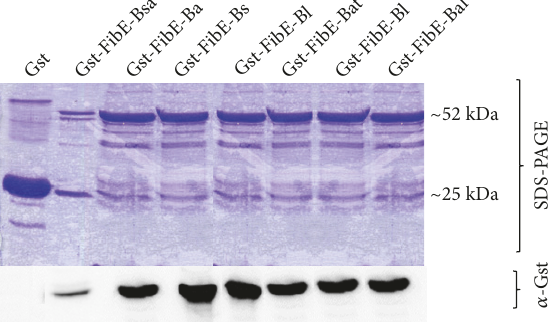
Figure 2: Coomassie blue staining of GST fused to derivatives (TOP) and anti-GST immunodetection.